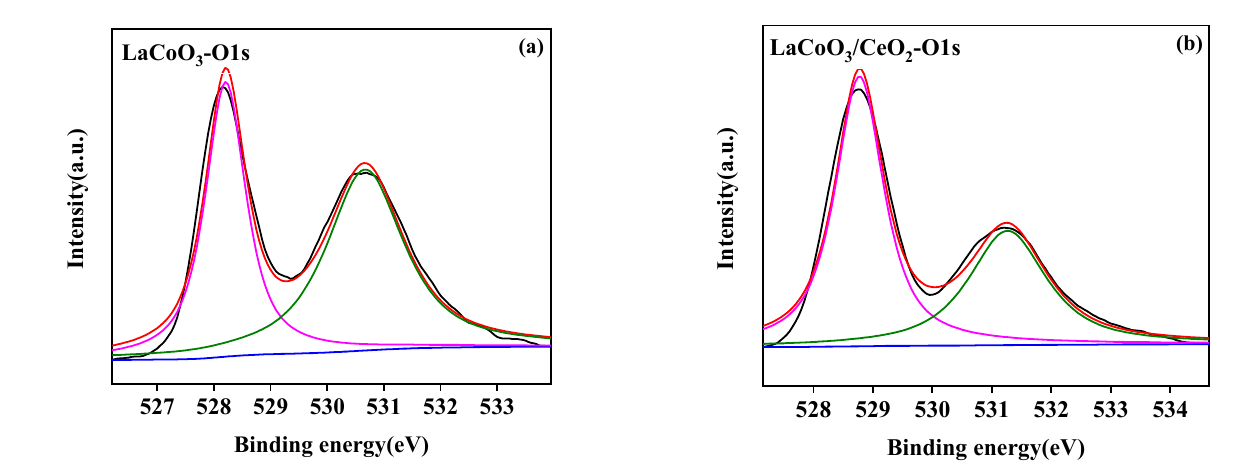
Figure 8. XPS spectra of Co 2p of LaCoO 3 ( a ) and LaCoO 3 /CeO 2 ( b ).